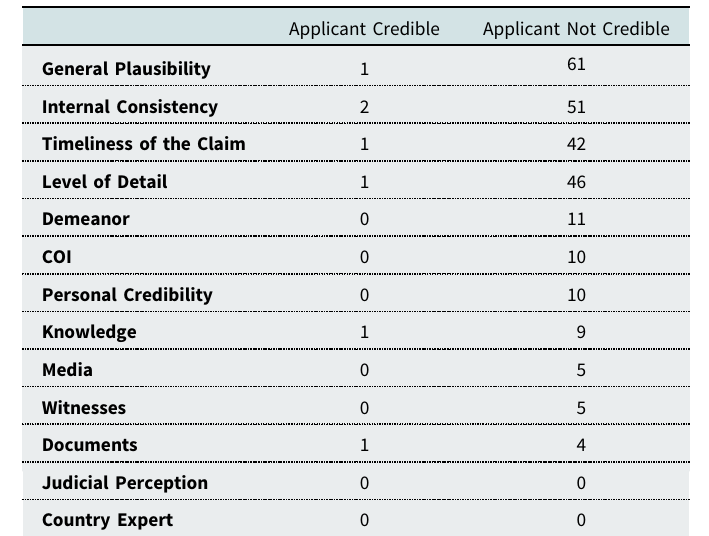
Table 5. Use of Negative Reality